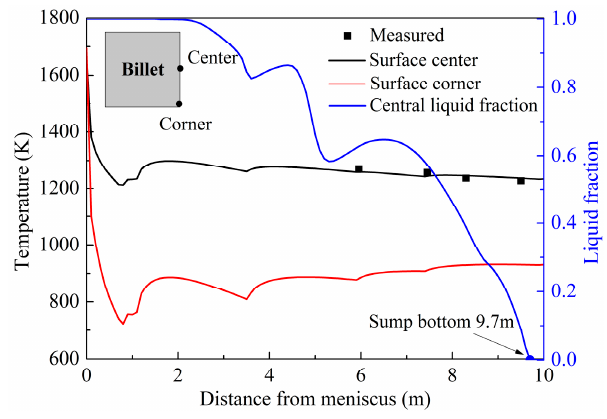
Figure 3. Evolution of solidification profiles along the casting direction.